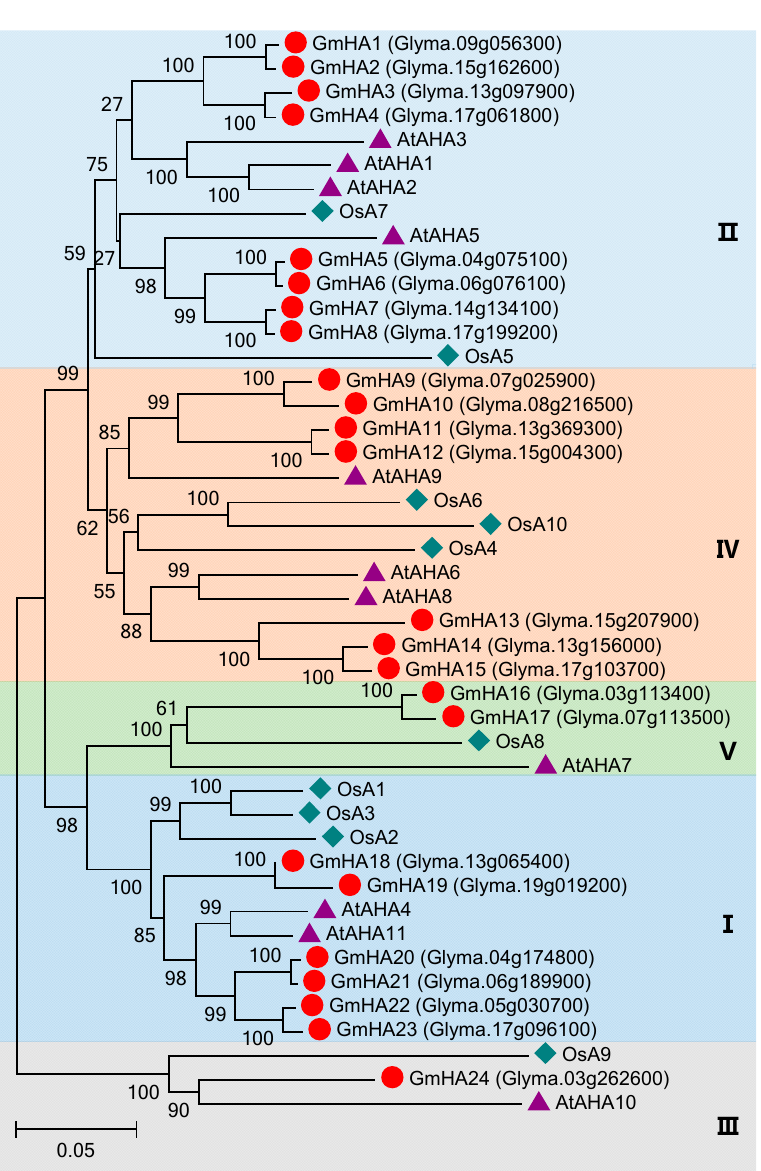
Figure 6. Phylogenetic tree soybean ( Glycine max ), rice ( Oryza sativa ), and Arabidopsis thaliana of the P3A subfamily: the full-length amino acid sequences were aligned by ClustalW. The phylogenetic neighbor-joining tree was made by MEGA6 with 1000 bootstrap replications. GmAHAs are denoted by red circles, AtAHAs are denoted by purple triangles, while OsAs are denoted by green diamonds. The locus name of a soybean gene is shown in brackets. Roman numerals designate the subfamilies.